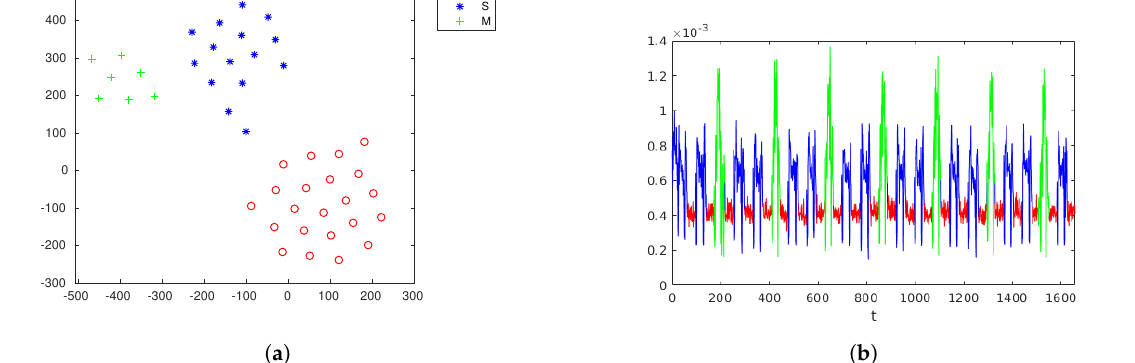
Figure 6. Key exponent recovery process. ( a ) t-SNE visualized polynomial coefficients clustered; ( b ) Recovering key exponent with the